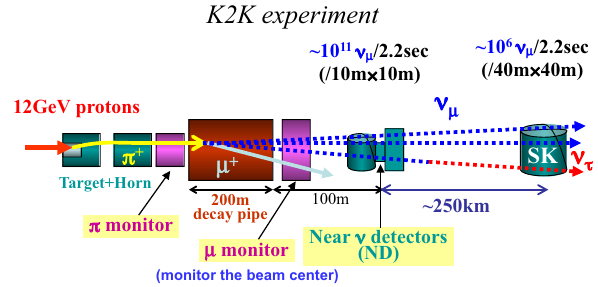
Fig. 11 Schematic view of the K2K